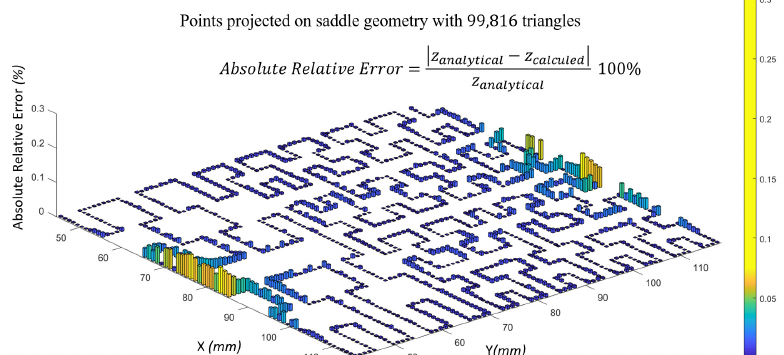
Figure 12. The absolute relative error for each point of trajectory with a maximum error of 0.287034% occurred at ( X = 80, Y = 42 ) and a mean error = 0.025853; the error was caused mainly by the resolution polygonal mesh. Plot generated using the script of [48].